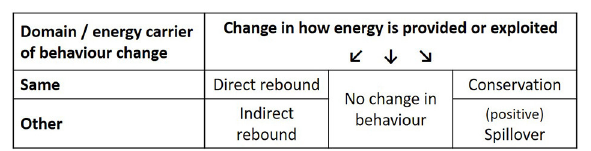
FIGURE 1 | Overview of potential behavioral consequences of the way how energy is used or